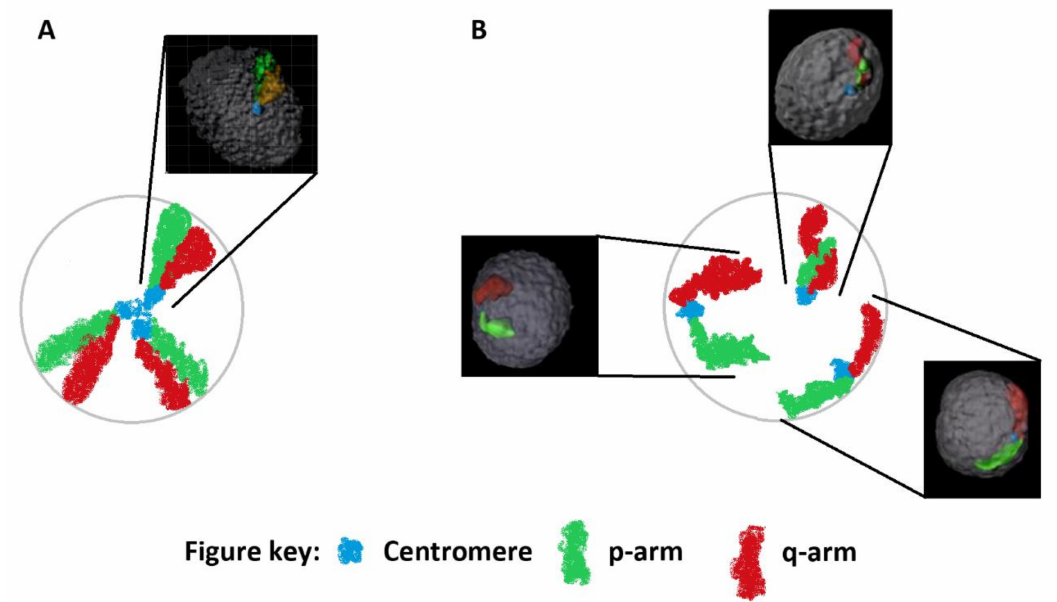
Figure 1. 3D rendered models and schematic diagrams illustrating two different models of chromosome organization and hairpin-loop configurations in human sperm. Schematic cross-section of a sperm nucleus, with magnified boxes that display 3D rendered models following sperm-FISH of the organization of centromeres (aqua), p-arms (green) and q-arms (red) in human sperm. Panel A: Displays the original chromocenter hairpin-loop model of sperm chromosome organization, whereby centromeres cluster in the nuclear interior of the sperm nucleus, forming one or more chromocenters, with the p- and q-arms stretching out toward the nuclear periphery. In the current study of 1240 cells, we rarely observed this type of chromosome configuration. This, alongside previously published data [10], led us to propose a refined hairpin-loop model of organization that is more segmentally arranged. Panel B: Segmental model of chromosome organization in human sperm. Here, we observe centromeres distributed throughout the nucleus and the chromosome arms forming narrow and wide hairpin-loops as well as displaying different orientations within the sperm nucleus. Additionally, in contrast to one study [29], we rarely observed chromosome arms to lie in parallel to one another leading to intermingling or coiling of the chromosome arms; with the majority of cells examined displaying discrete non-overlapping territories for the chromosome